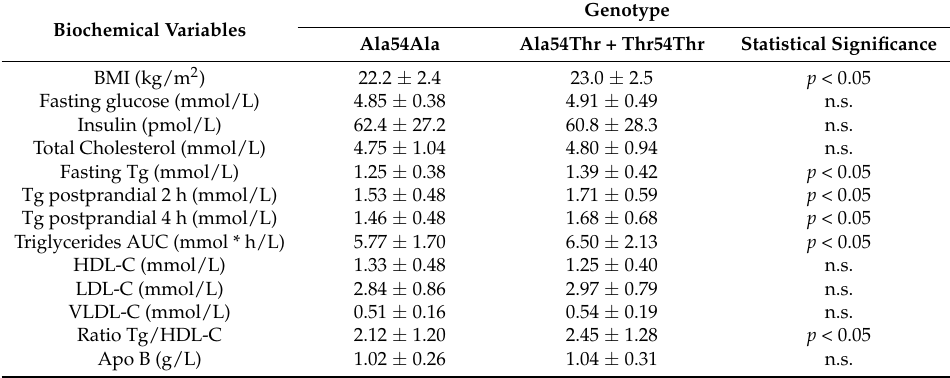
Table 3. Biochemical parameters according to FABP2 genotype.